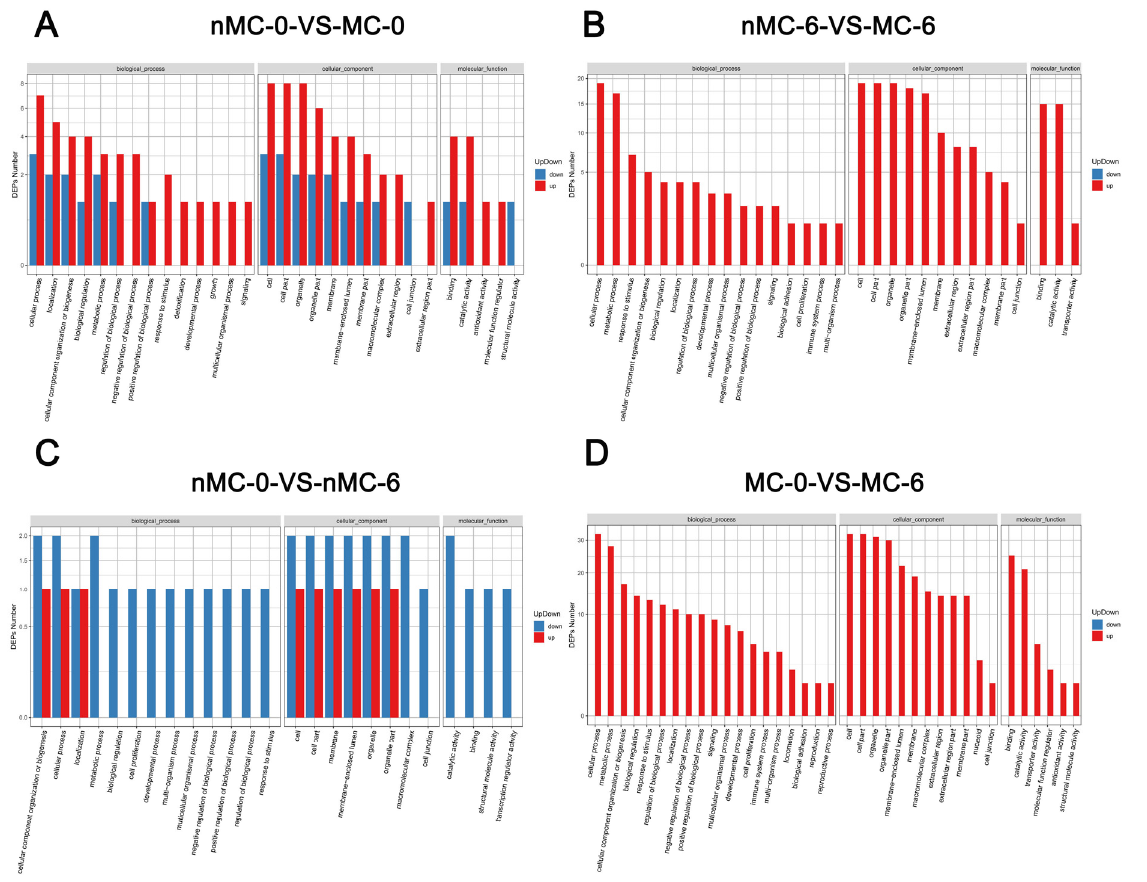
Figure 4. GO functional classification map of differential proteins associated with mitochondrial of cryopreserved human oocytes from the nMC-0 group, MC-0 group, nMC-6 group and MC-6 group. ( A ) nMC-0 VS MC-0: Comparison of up-and down-regulated differential proteins between nMC-0 group and MC-0 group; ( B ) nMC-6 VS MC-6: Comparison of up-and down-regulated differential proteins between nMC-6 group and MC-6 group; ( C ) nMC-0 VS nMC-6: Comparison of up-and down-regulated differential proteins between nMC-0 group and nMC-6 group; ( D ) MC-0 VS MC-6: Comparison of up-and down-regulated differential proteins between MC-0 group and MC-6 group. The red represents up, the blue represents down. Table 2. Statistical table of the number of differential proteins related to mitochondrial function in each group.